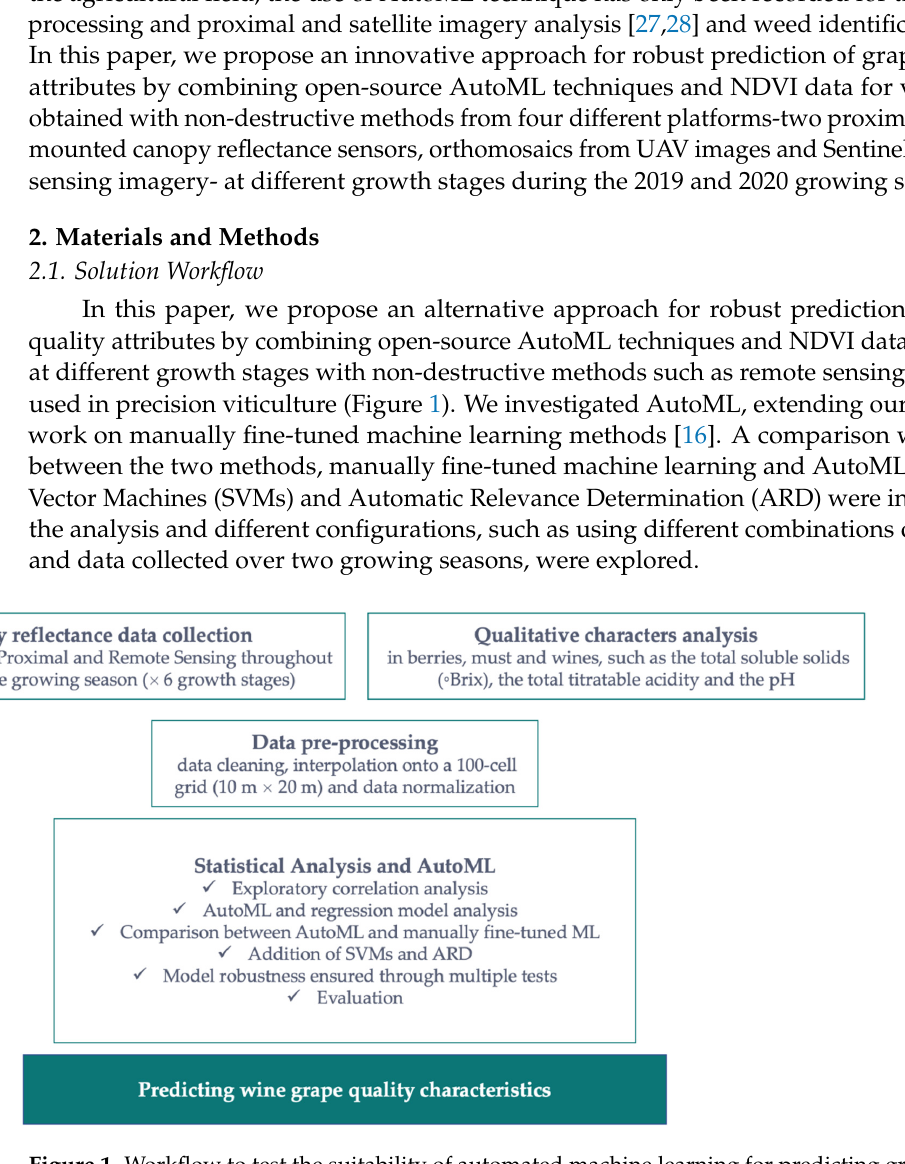
Figure 1. Workflow to test the suitability of automated machine learning for predicting grape sugars using NDVI data from proximal and remote